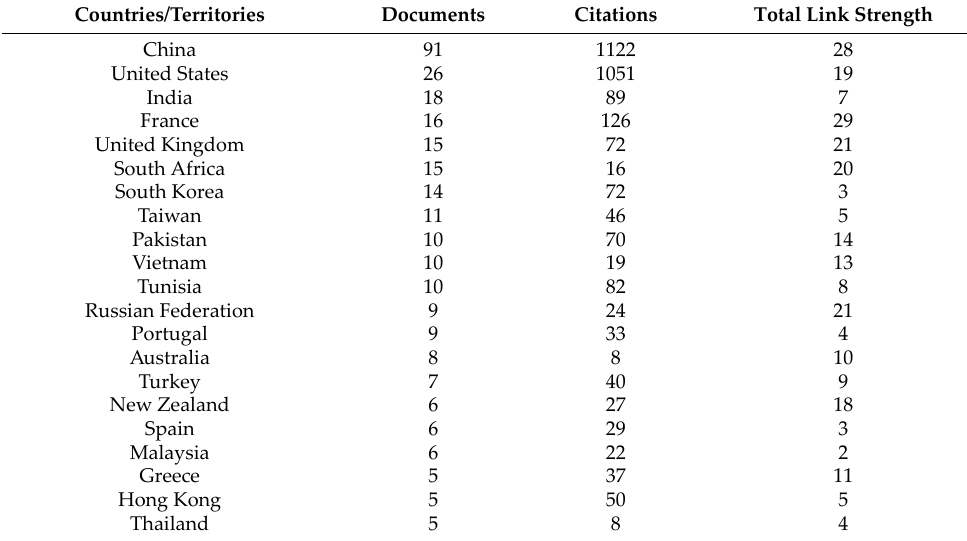
Table A1. Country/territory‑wise research documents and